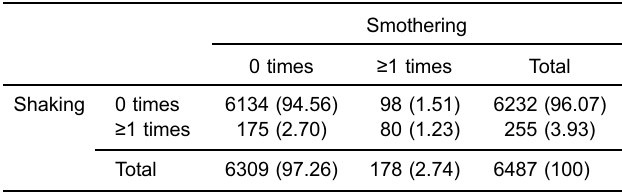
Table 2. Association of prevalence